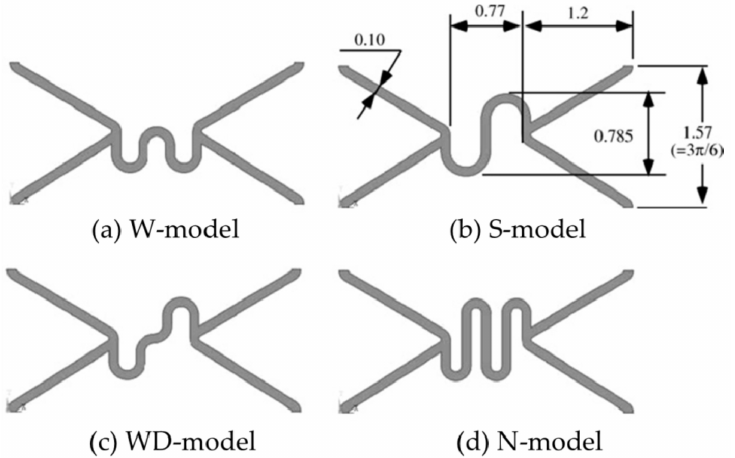
Figure 11. Four different model structures [104]: ( a ) W-model; ( b ) S-model; ( c ) WD-model; ( d ) N-model.